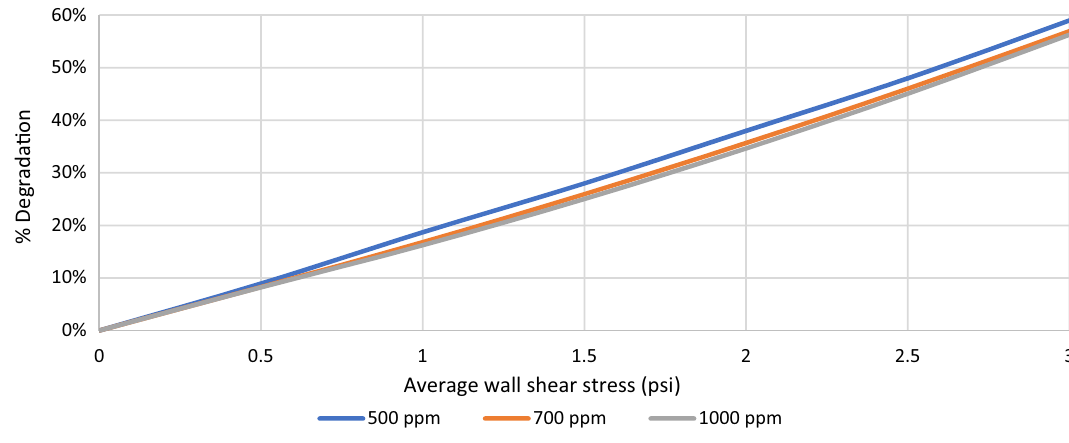
Fig. 12 Effect of the HPAM concentration in the percentage of